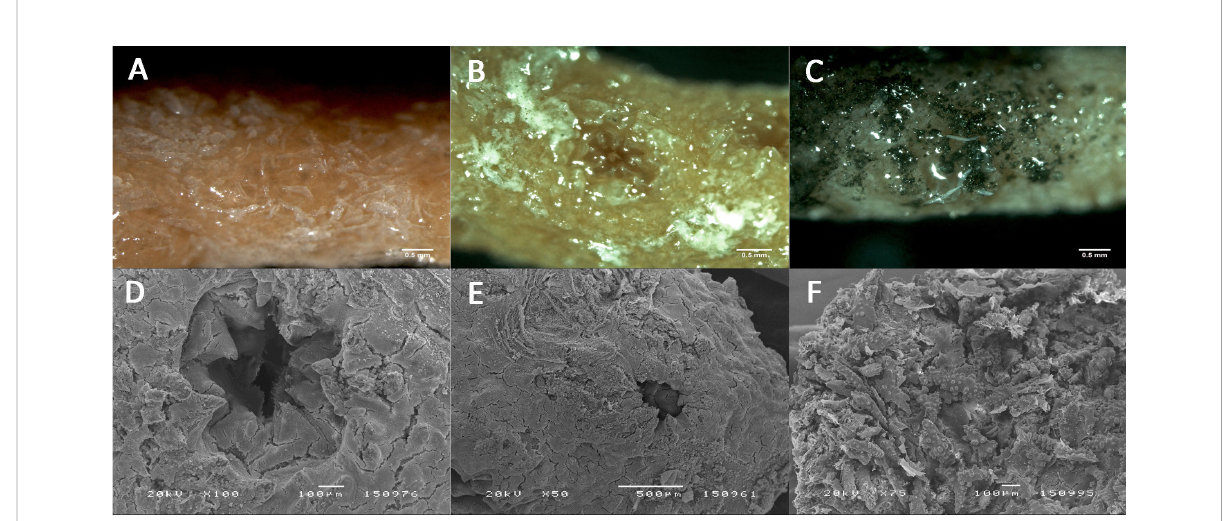
FIGURE 4 Tissue and polyps condition of Dentomuricea aff. meteor after 13 days exposure to the different treatments. (A, D) Control treatment; (B, E) ; Quartz particle treatment; (C, F) Polymetallic sulphide treatment. Photographs A, B, C taken under the dissection microscope; photographs (C-E) taken under the scanning electron